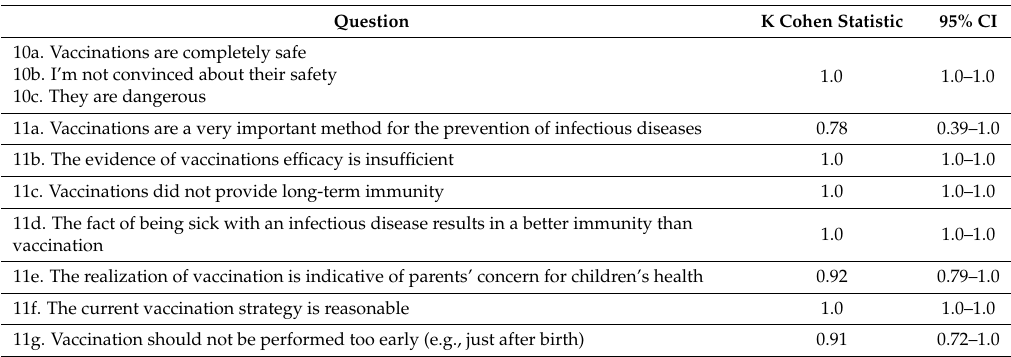
Table 1. Repeatability of answers to selected questions, values of Kappa-Cohen statistics along with 95% confidence intervals (95%